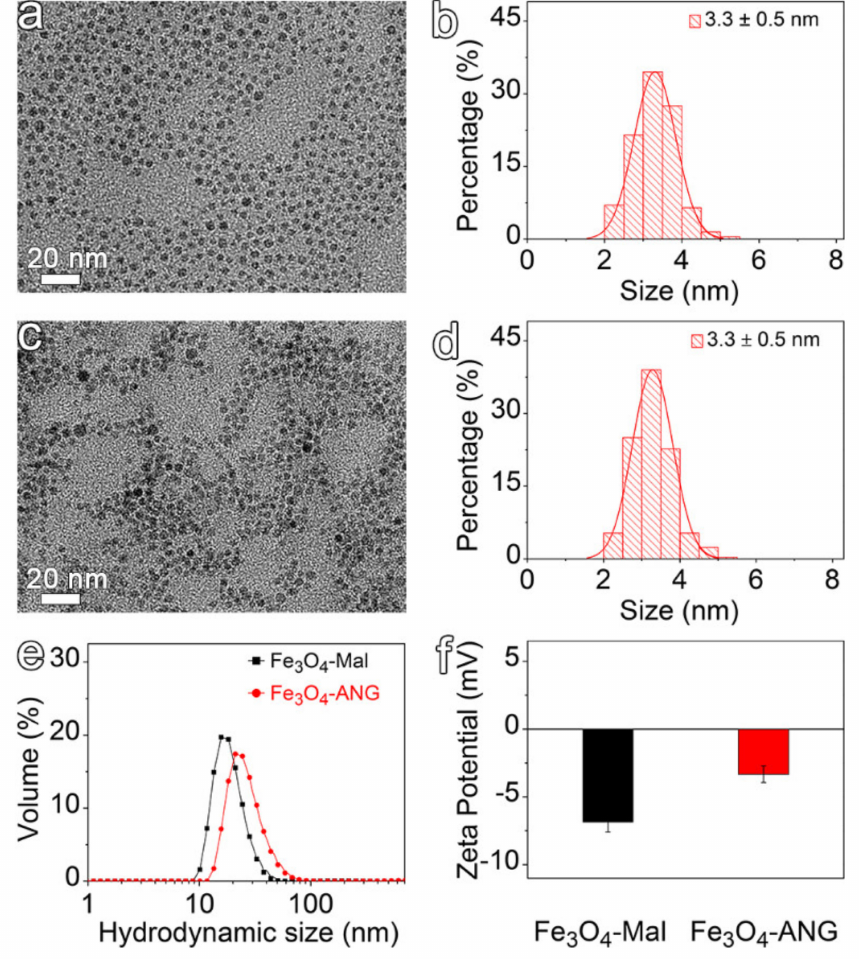
Figure 1. ( a ) TEM analysis and ( b ) size distribution of as-synthesized hydrophobic Fe 3 O 4 NPs. ( c ) TEM image and ( d ) size distribution of Fe 3 O 4 -ANG NPs. ( e ) Hydrodynamic size distribution profiles and ( f ) Zeta potential values of Fe 3 O 4 -Mal and Fe 3 O 4 -ANG